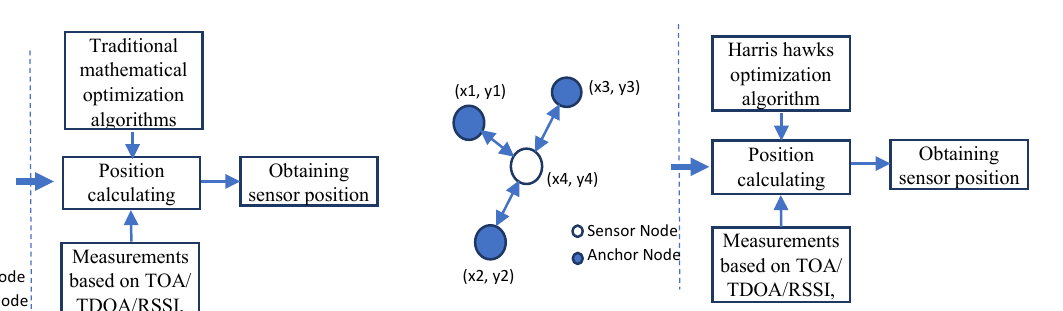
Figure 2. Anchor-based sensor nodes localization approach using harris hawks optimization algorithm